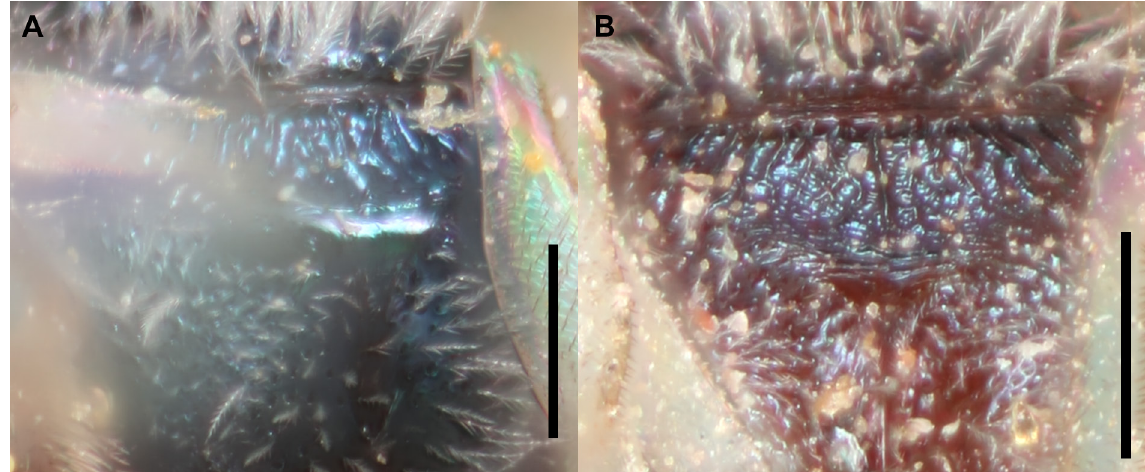
Fig. 114. Metapostnotum. A . Lasioglossum gaudiale (Sandhouse, 1924), ♂, shiny with subparallel rugae. B . L. stictaspis (Sandhouse, 1923), ♂, dull with anastomosing rugae. Scale bars = 0.25